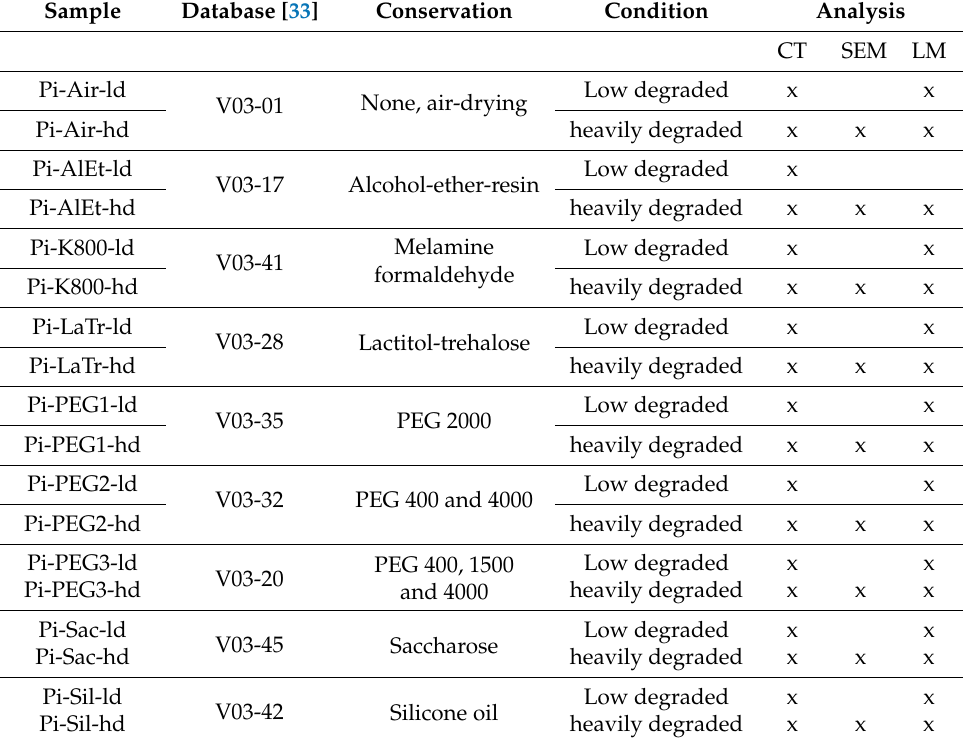
Table A2. Overview over the samples and methods of investigation. For each analysis (marked with x), one sample was prepared from a core sample. In all, five samples were analyzed for each conservation